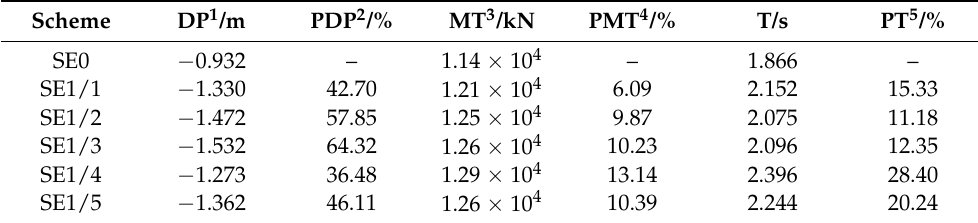
Table 3. Results of schemes that delete one virtual ring.